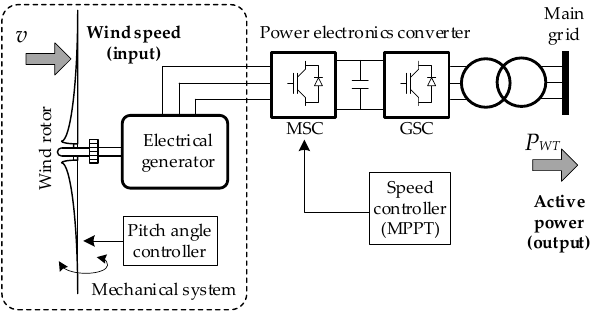
Figure 2. VSWT model connected to the grid.